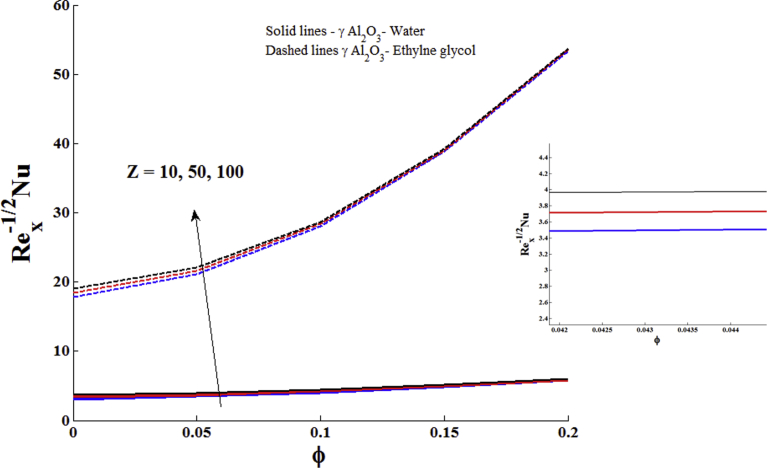
Impact of nanoparticle volume fraction and modified Hartmann number reduced Nusselt number with Pr = 6.96 (γ Al2O3- Water) and Pr = 204 (γ Al2O3- Ethylene glycol).